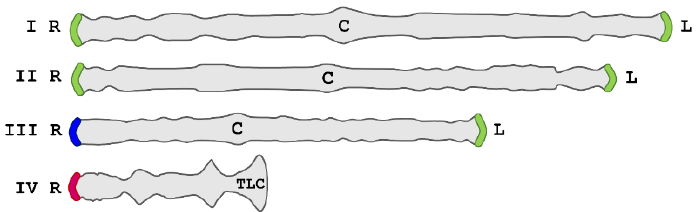
Figure 1. Chironomus riparius genome. Schematic representation of the Chironomus riparius chromo- somes (I–IV). All telomeres except the telocentric end of the chromosome 4 (TLC) consist of large blocks of 176-bp repeat sequences. Three subfamilies of telomeric sequences have been described, which are differently distributed: TsA (blue) in telomeres III-R, TsC (pink) in telomeres IV-R, and TsB (green) in the other nontelocentric telomeres. Telomeric ncRNAs studied in this work, CriTER-A and CriTER-B, are the sense TsA and TsB transcripts, respectively. No TsC or TLC transcripts have been detected [24]. R, right; L, left; C, centromere.